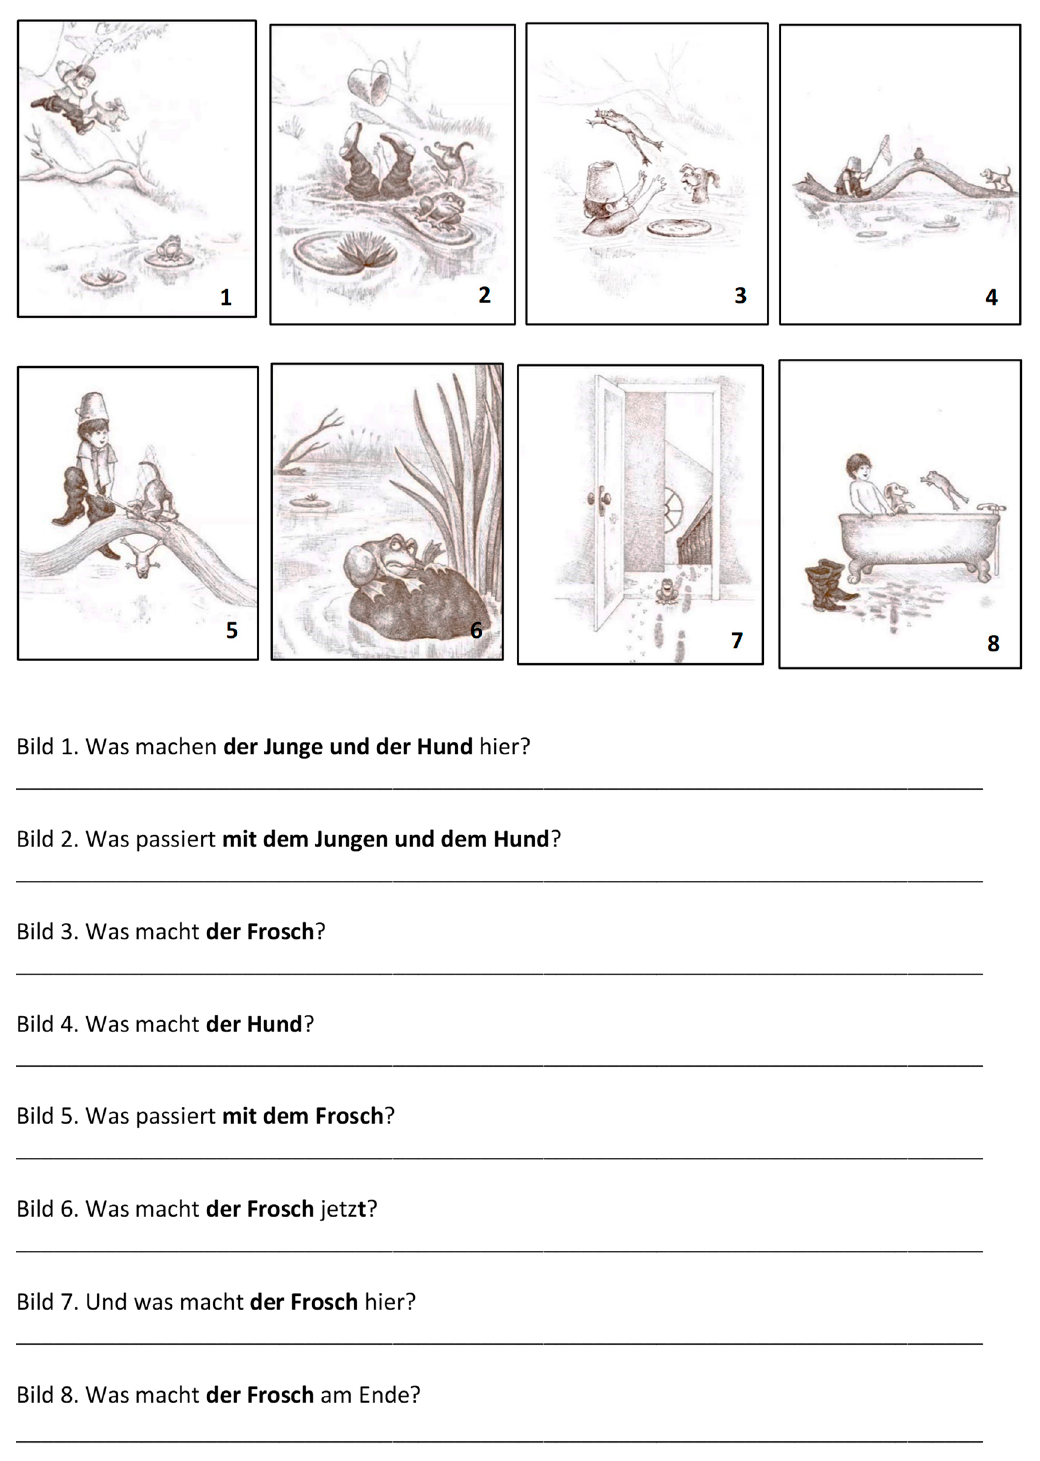
Figure A12. Posttest: Production task.